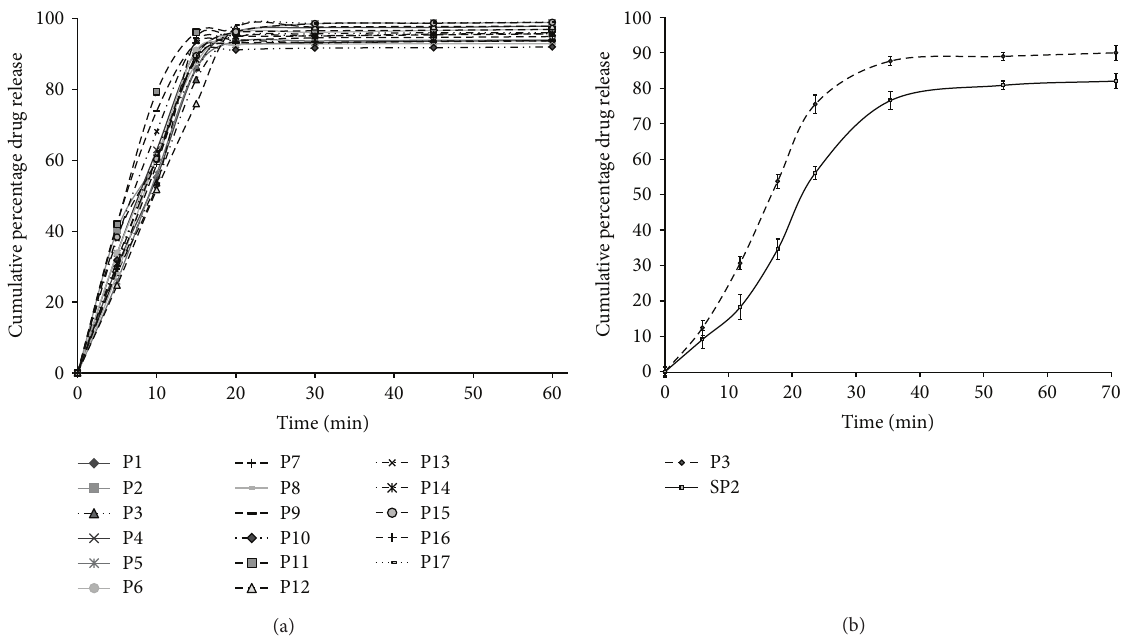
Figure 5: (a) Mean percent curcumin released for the optimal formulations ( 𝑛 = 3 ). (b) Mean percent curcumin released for the optimal formulations (P3 and SP2) ( 𝑛 = 3 ).